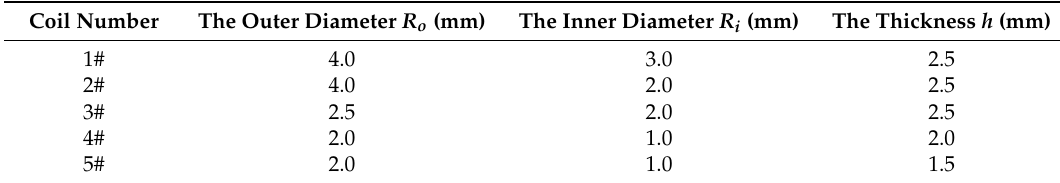
Table 1. Parameters of the probe coil.